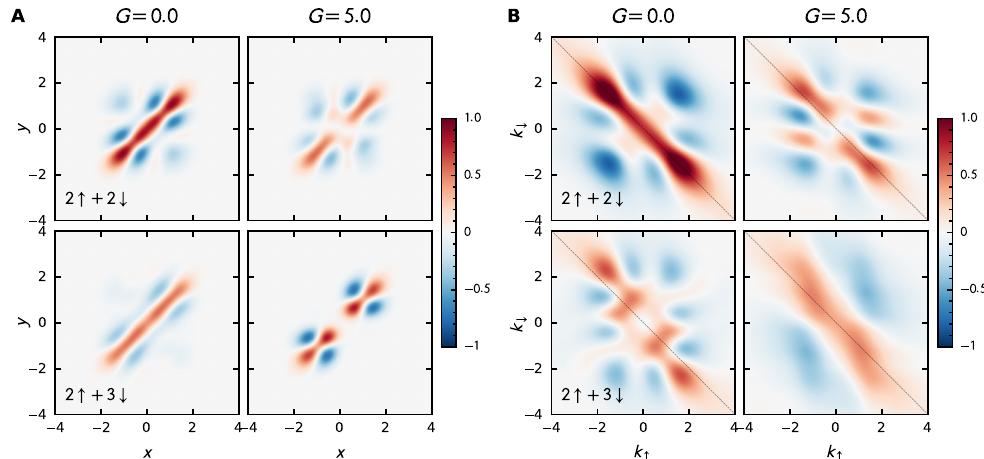
Figure 7: Density-density correlation functions. (A) Real space correlation func- tion, G r . (B) Momentum-space correlation function, G k . All panels have g = − 2.0, ↑↓ ↑↓ with ( G = 5.0, right columns) and without ( G = 0, left columns) the magnetic im- purity. The top row is for the 2 ↑ + 2 ↓ system; the bottom row is for 2 ↑ + 3 ↓ . The dashed lines in panel B show the anti-diagonal k ↓ = − k ↑ where pairing in the bal- anced case is expected. In both panels red and blue values correspond to positive and negative correlation, respectively. The colormaps are in arbitrary units and normal- ized such that the uncorrelated values correspond to 0 (white) as well as maximal positive correlation corresponds to